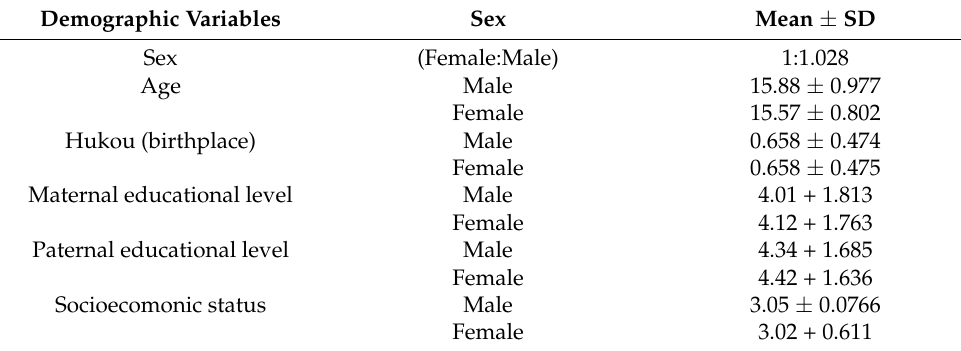
Table 1. Participants’ demographic